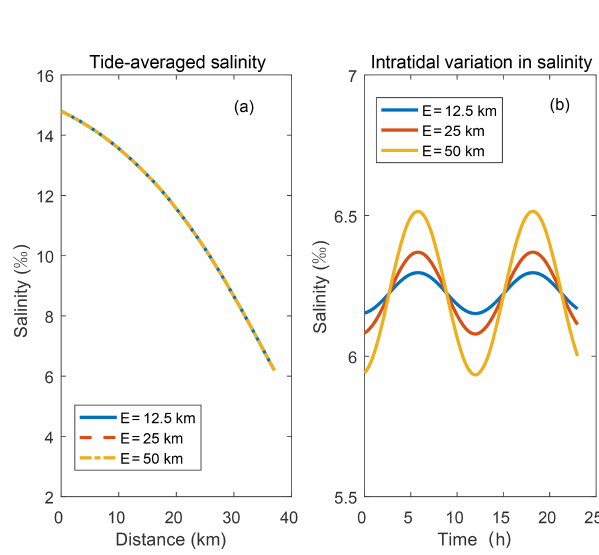
Figure 10. (a) Longitudinal salt intrusion curve at tidal average, considering different tidal excursion values; (b) intratidal variation in salinity at Huangpuyou station on 31 January 2005, considering different tidal excursion